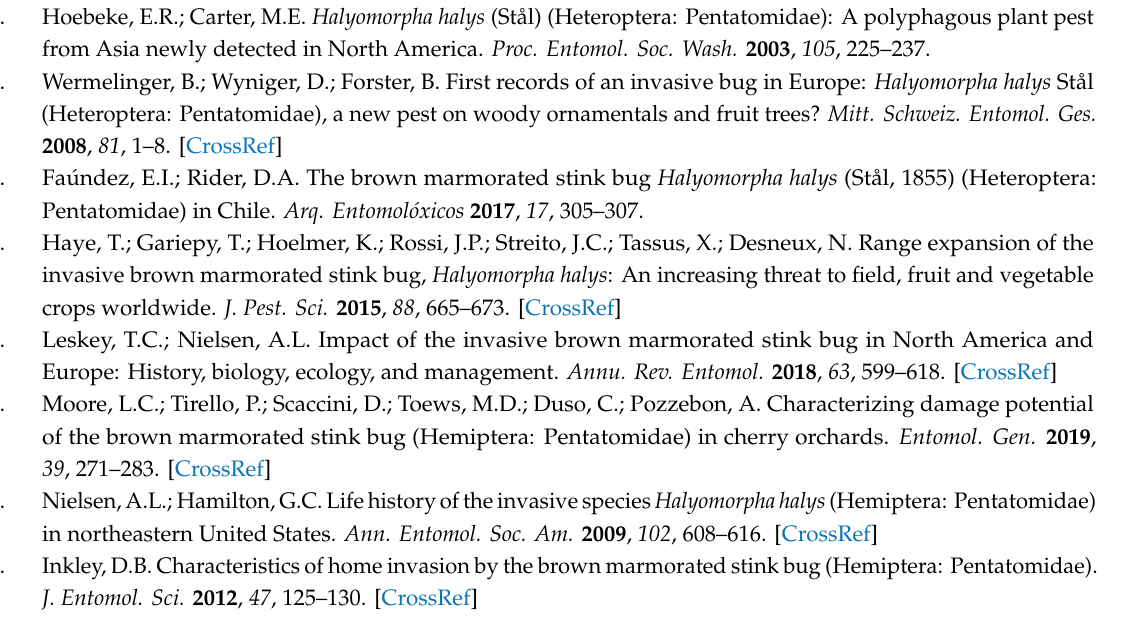
Table S1: Overview of fates and parasitism of Halyomorpha halys egg masses collected in the study site of Auer (Ora), Trentino-Alto Adige (Site 3) in September and October